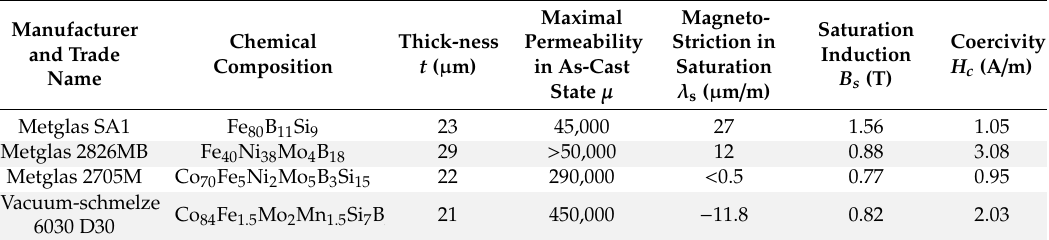
Table 1. A summary of the essential properties of the compared amorphous ribbons